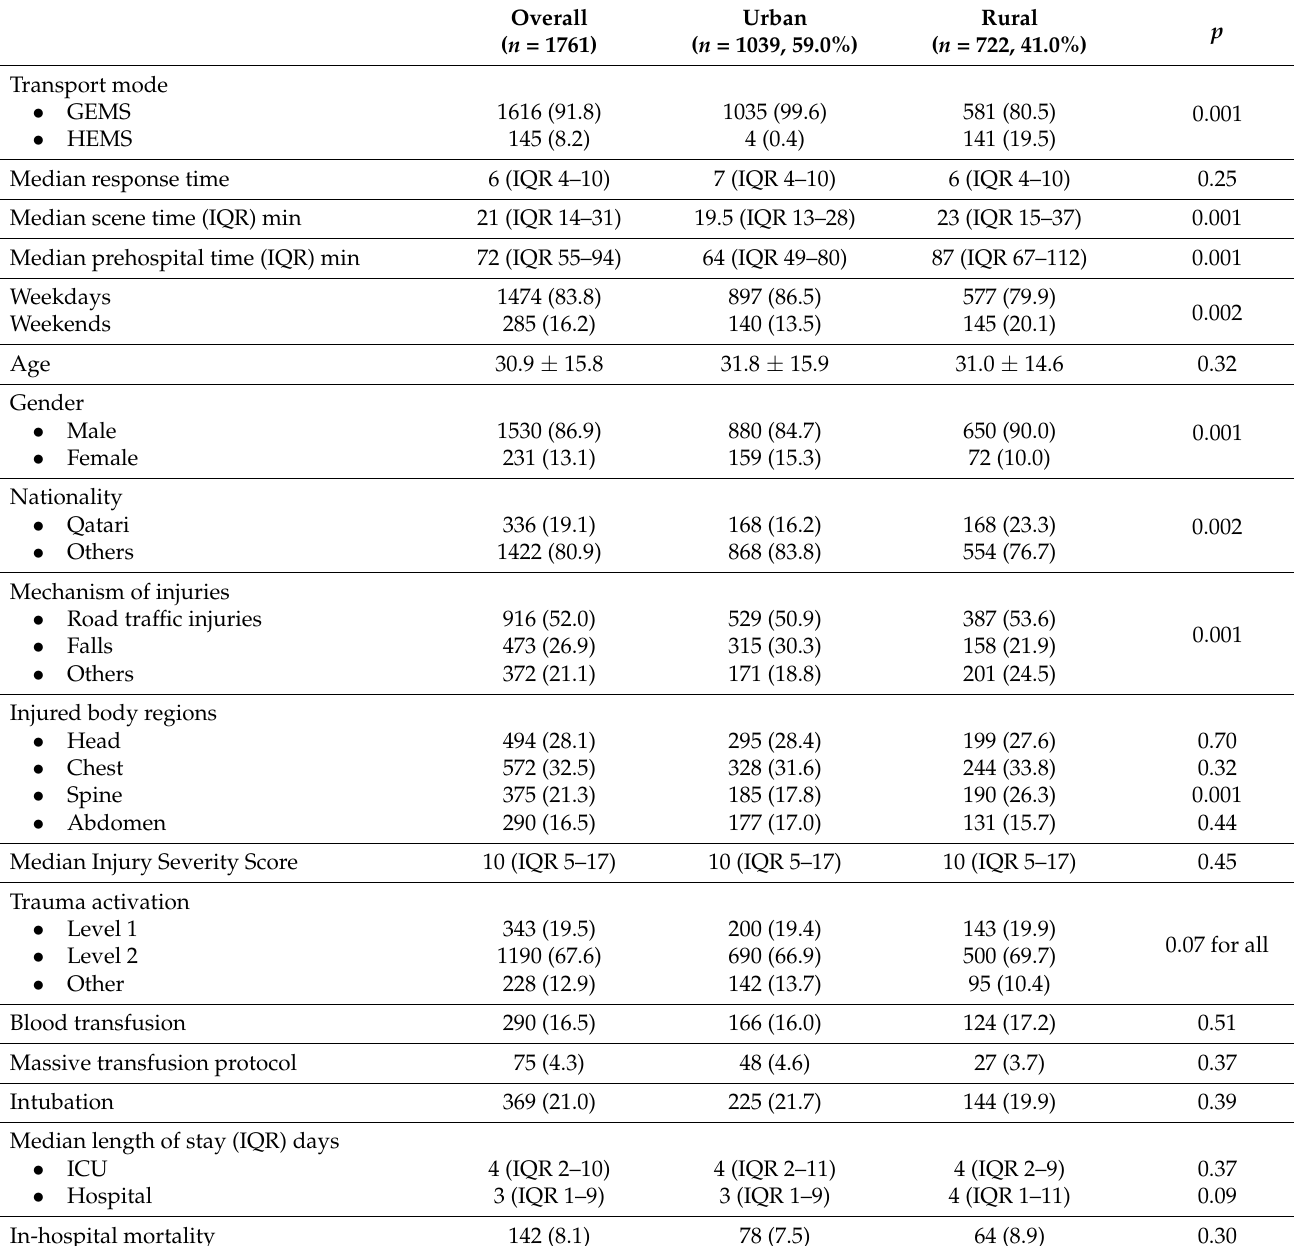
Table 1. Characteristics and outcomes of trauma patients transported by EMS from urban and rural